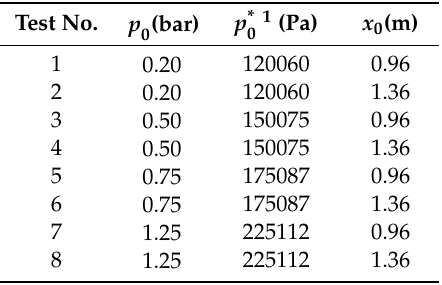
Table 1. Characteristics of